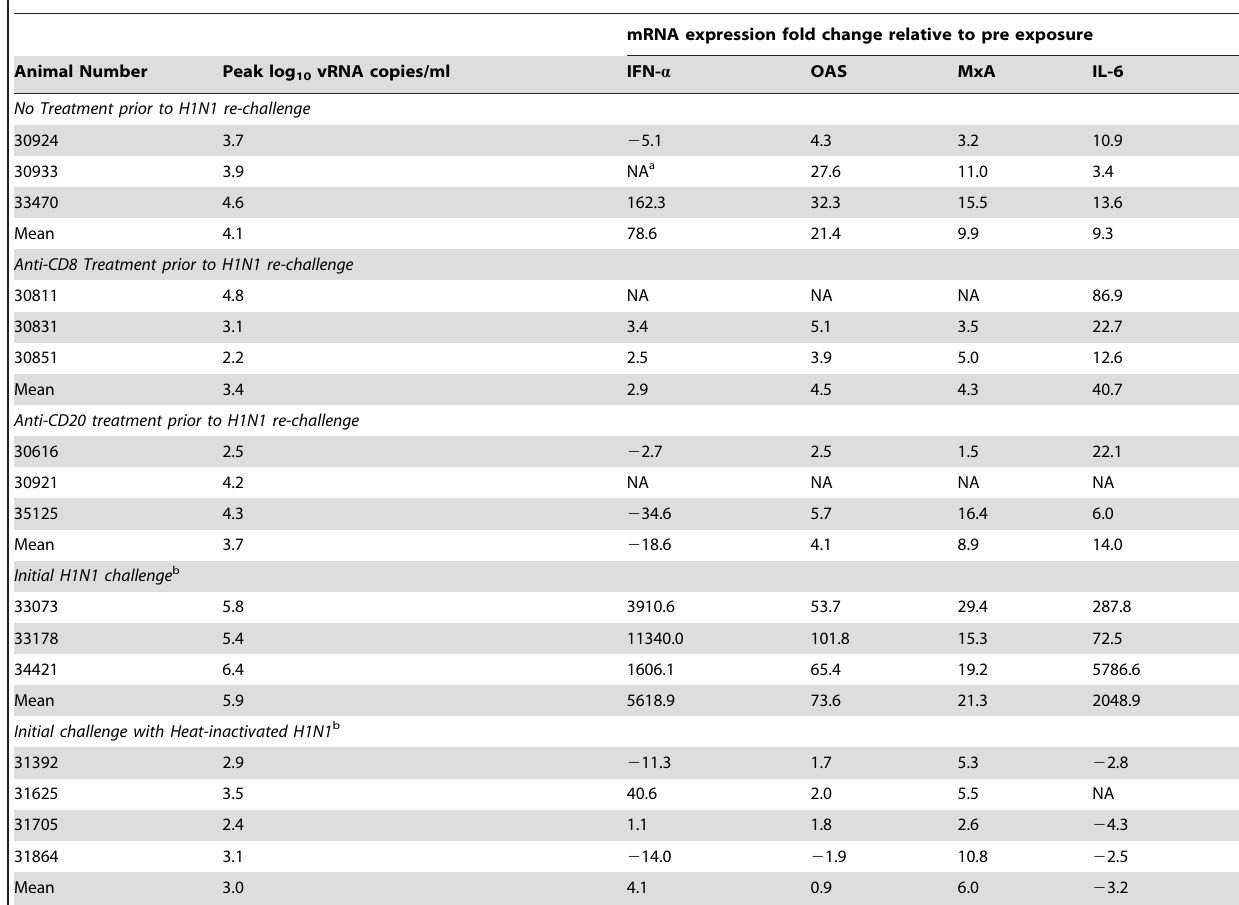
Table 3. Influenza virus RNA and host gene mRNA levels in tracheal secretions 24 hours after initial A/Memphis/7/2001 (H1N1) challenge; H1N1 re-challenge; or challenge with heat-inactivated H1N1.